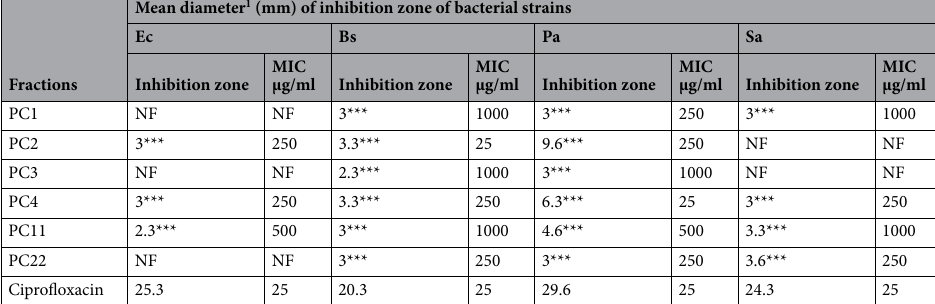
Table 5. Anti bacterial activity of fractions of M. paniculata hexane extracts. Ec: Escherichia coli , Bs: Bacillus subtilis , Pa: Pseudomonas aeruginosa, Sa: Staphylococcus aureus. NF: Not found any zone of inhibition. 1 n = 3 Standard error was < 15% of mean in all cases. P value (***) represents very highly significant difference over the standard